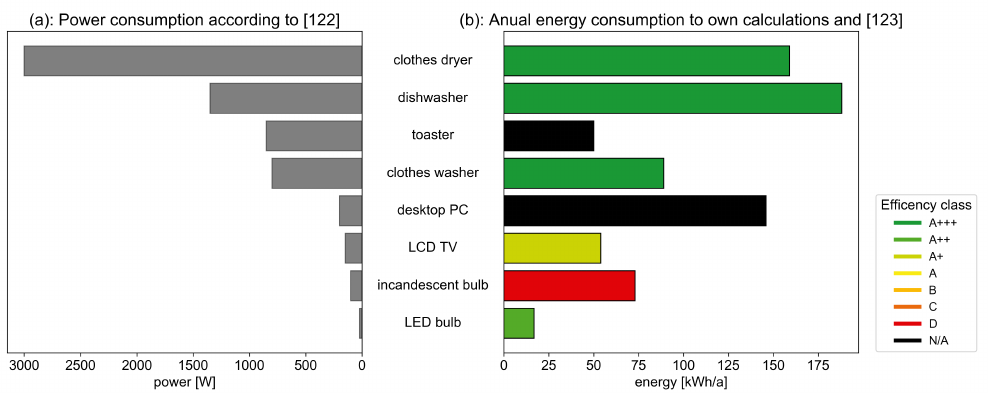
Figure 5. ( a ) Electrical power consumption of typical household appliances. Power data are gained from [122]. ( b ) Electrical energy consumption of typical household appliances. The data